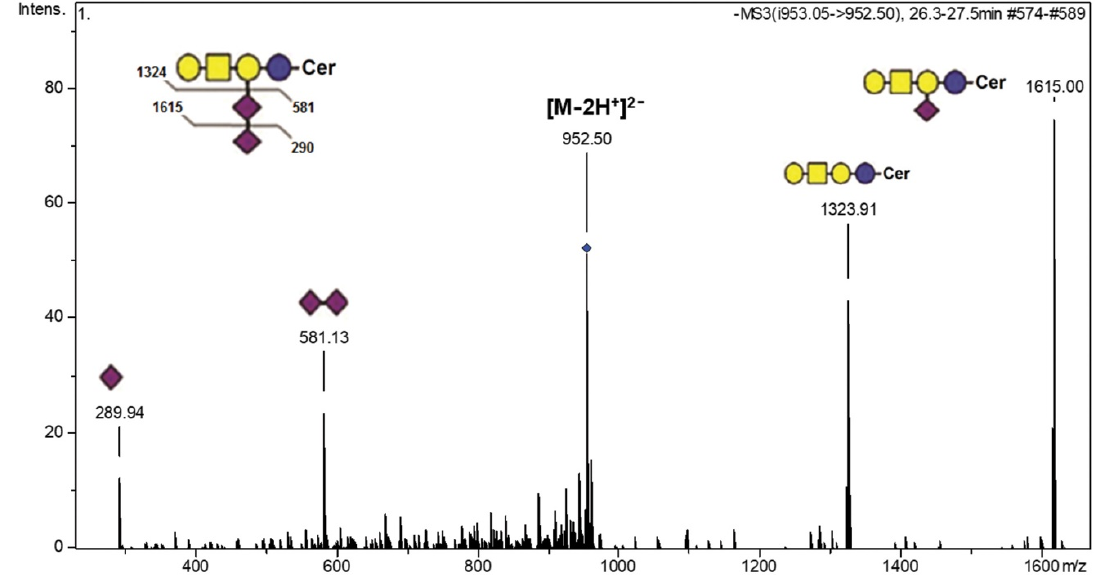
Figure 4. Fragmentation spectra obtained via CID MS 2 of [M-H] − ions at m/z 1516.93 ( a ) and m/z 1544.94 ( b ) confirming GM1a and GM1b isomer structures with d18:1/16:0 ( a ) and d18:1/18:0 ( b ) ceramide compositions in a ganglioside mixture from anaplastic ganglioglioma tumor tissue.